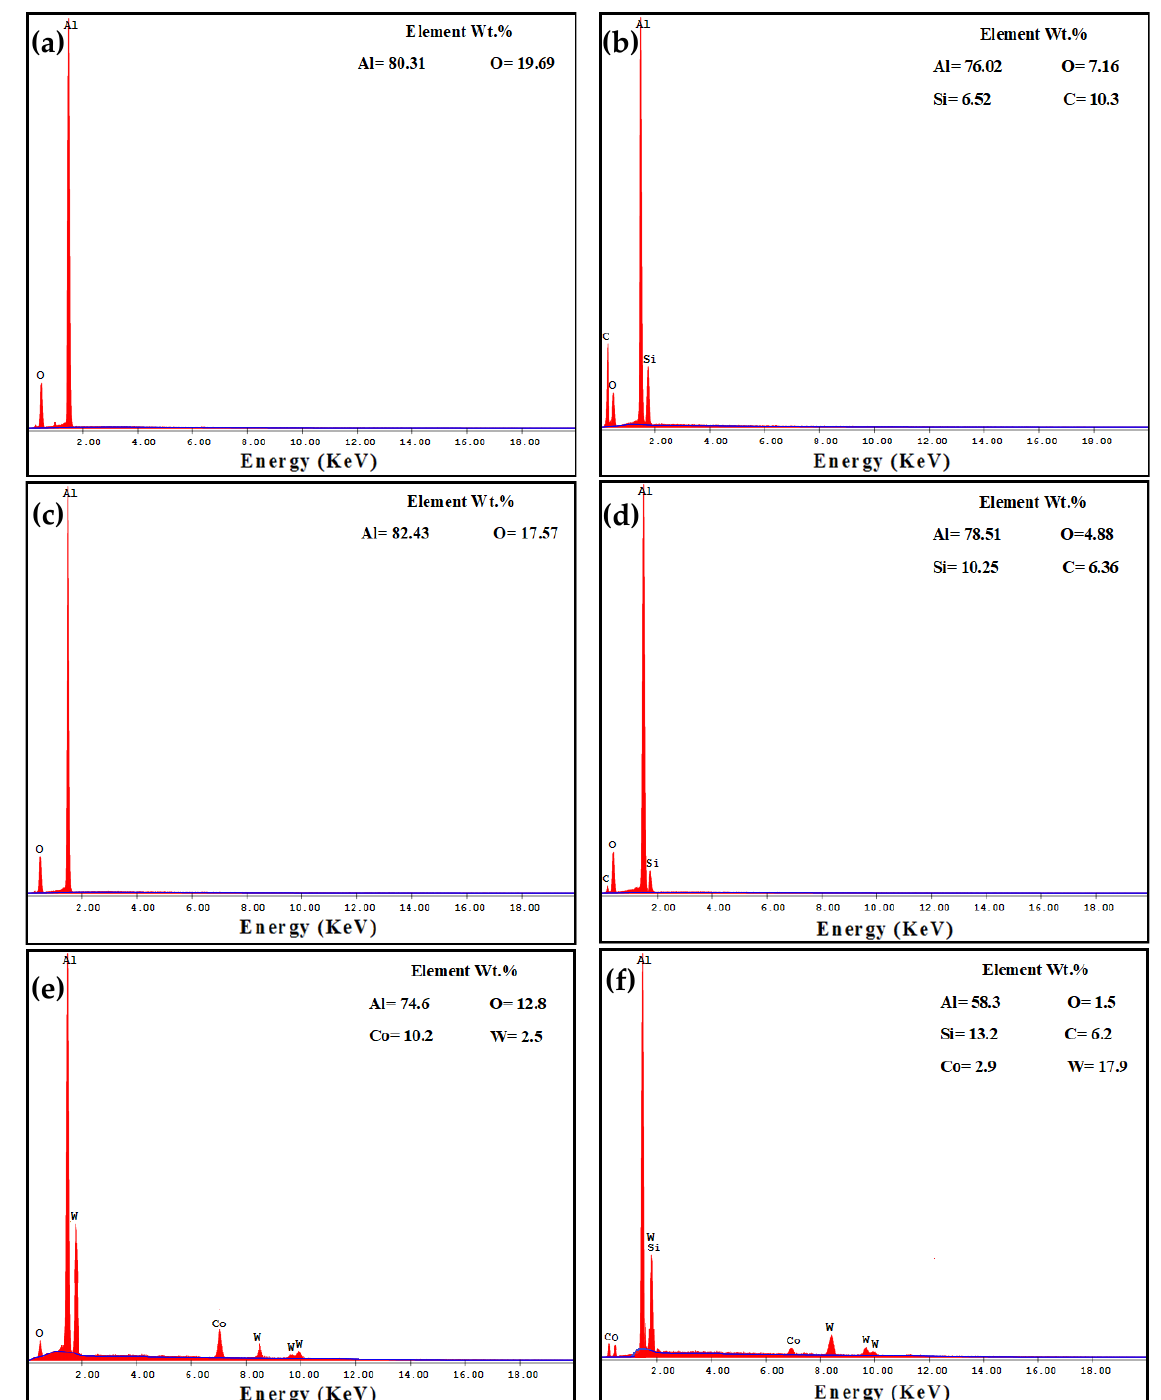
Figure 12. EDS analysis of the worn surface morphology of ( a ) PM Al-20% Al 2 O 3 , ( b ) PM Al-20% SiC, ( c ) HPT-processed Al-10% Al 2 O 3 , ( d ) HPT-processed Al-10% SiC, ( e ) HPT-processed Al-20% Al 2 O 3 , and ( f ) HPT-processed Al-20% SiC samples obtained under an applied load of 20 N and a sliding distance of 1260 m.